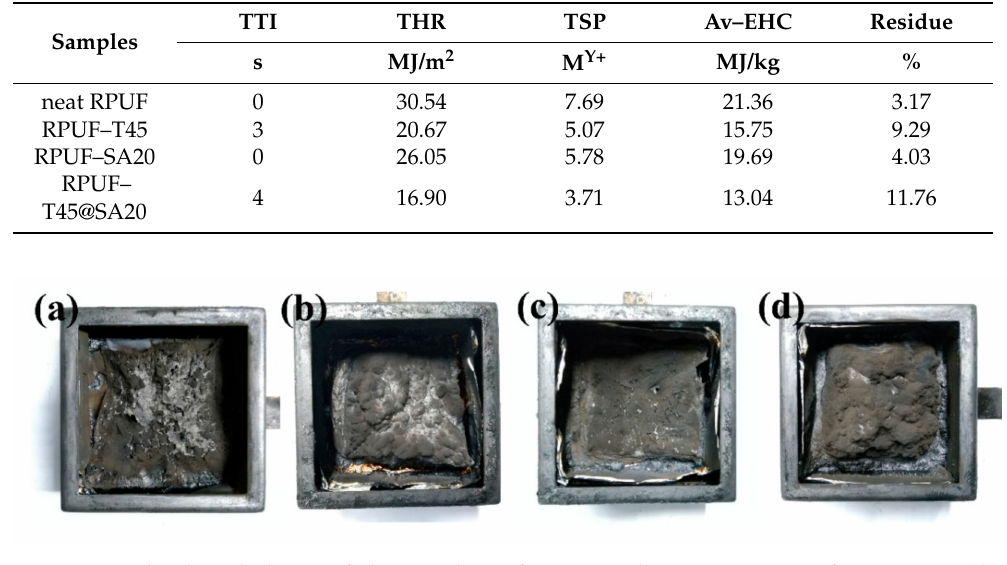
Figure 11. The digital photos of char residues after cone calorimeter testing of neat RPUF ( a ), RPUF–T45 ( b ), RPUF–SA20 ( c ) and RPUF–T45@SA20 ( d